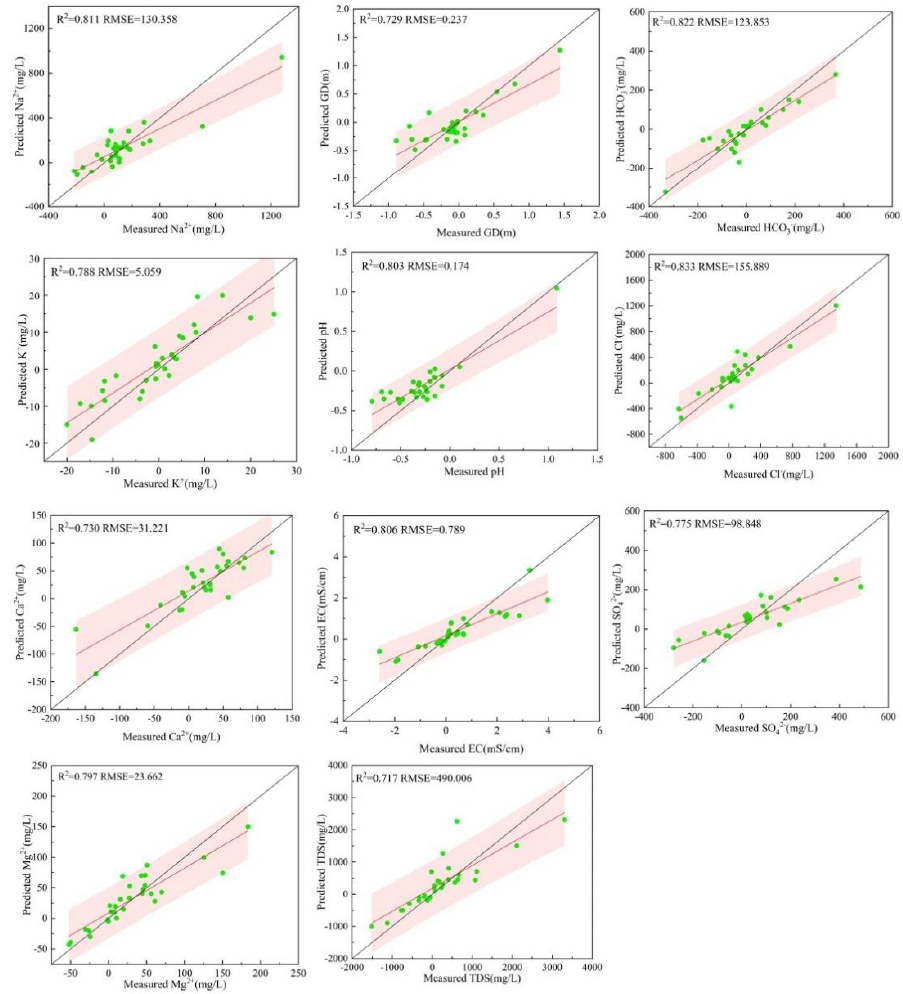
Figure 9. Scatter plot for accuracy verification of groundwater parameter difference inversion results (the bright pink area in the figure covers the true fit line with 95% probability, The red line is the fitted line, the black line is the 1:1 isoline, Scatter plots of laboratory-measured groundwater parameters with RF in the calibration and validation datasets).